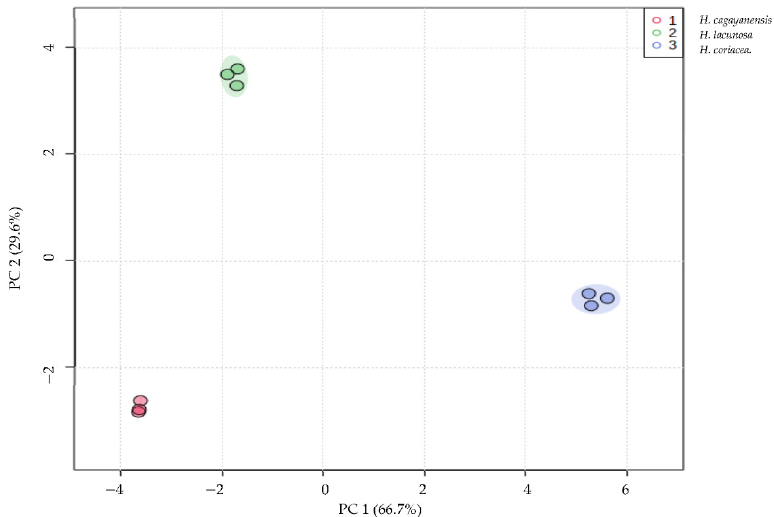
Figure 1. Principal component analysis (PCA) plot of metabolites from three species of Hoya . Each colour in scores plot represents a different species; H. cagayanensis (red), H. lacunosa (green), and H. coriacea (blue).